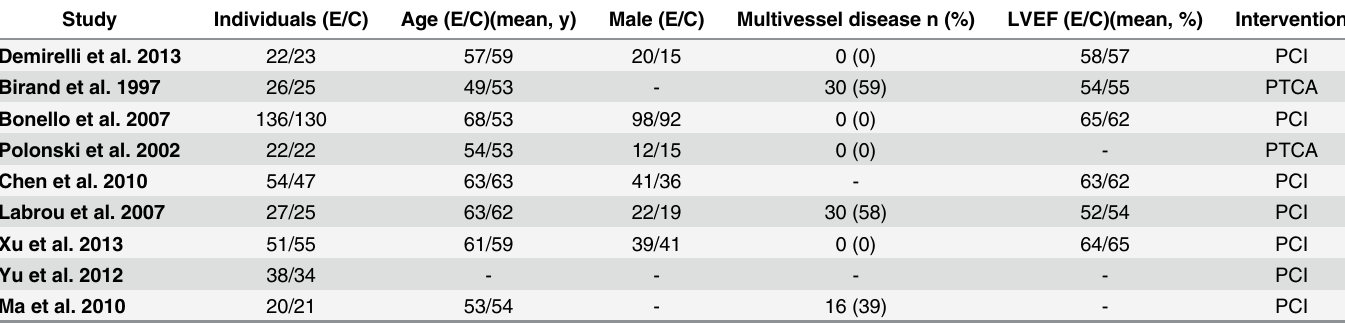
Table 1. Description of the Characteristics of Trials Included in the Meta-Analysis.